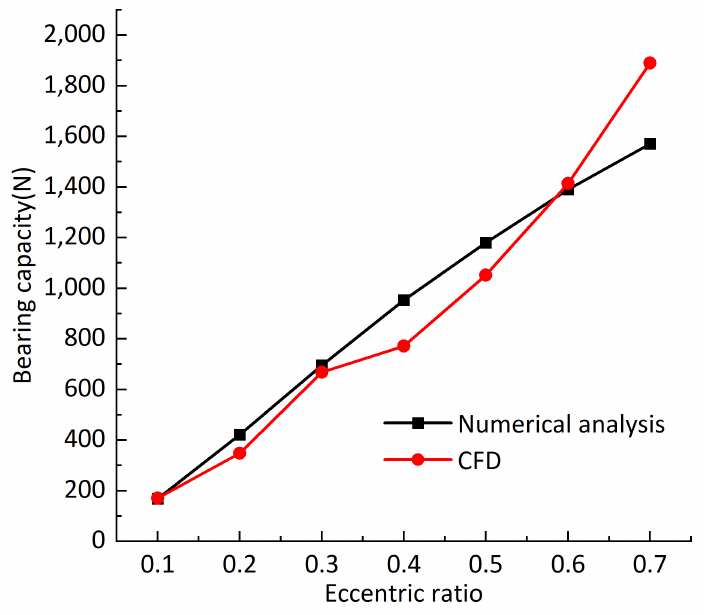
Figure 6. Influence curve of eccentricity on bearing capacity under two